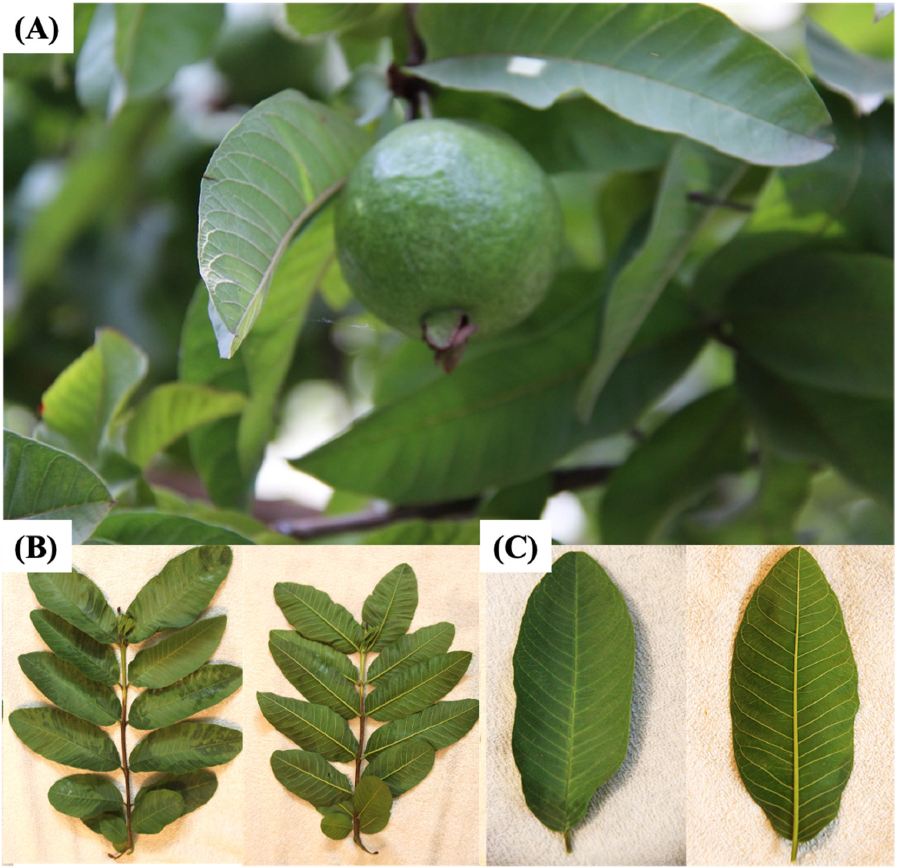
Figure 1. ( A ) Guava fruit and leaves, ( B ) bunch of guava leaves with dorsal view on the left and ventral view on the right, ( C ) guava leaf with dorsal view on the left and ventral view on the right. GLs are widely employed for treating diarrhea and digestive ailments, while the fruit pulp is utilized to enhance the platelet count for treating dengue fever. The potential of guava leaf extracts for diarrhea treatment was also studied [11,12]. The flavonoids present in guava leaf extract chiefly determine their antibacterial activity, while quercetin, which is the most predominant flavonoid of guava leaves, exhibits strong antidiarrheal activities. The antidiarrheal activity of quercetin is ascribed to its relaxing effect on the intestinal muscle lining which prevents bowel contractions. Guava leaf polysaccharides (GLPs) can be utilized as an antioxidant additive in food and for diabetes treatment. The presence of a unique variety of bioactive polyphenolic compounds, like querce- tin and other flavonoids, and ferulic, caffeic, and gallic acids, present in guava leaves pri- marily determine their bioactive and therapeutic properties [8,13]. These phenolic com- pounds are known as secondary metabolites which exhibit strong antioxidant and im- munostimulant activities. This review aims to discuss the various nutritional and bioac- tive compounds present in guava leaves and decipher the molecular basis of their phar- macological and medicinal properties concerning human health, nutrition, and as com- plementary medicine.